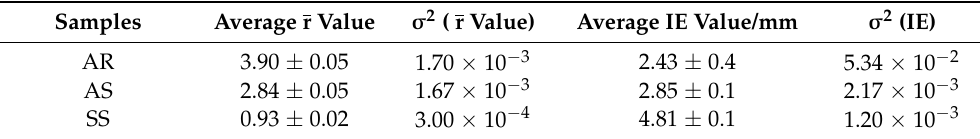
Table 2. Average value and variance in r value and IE value for various